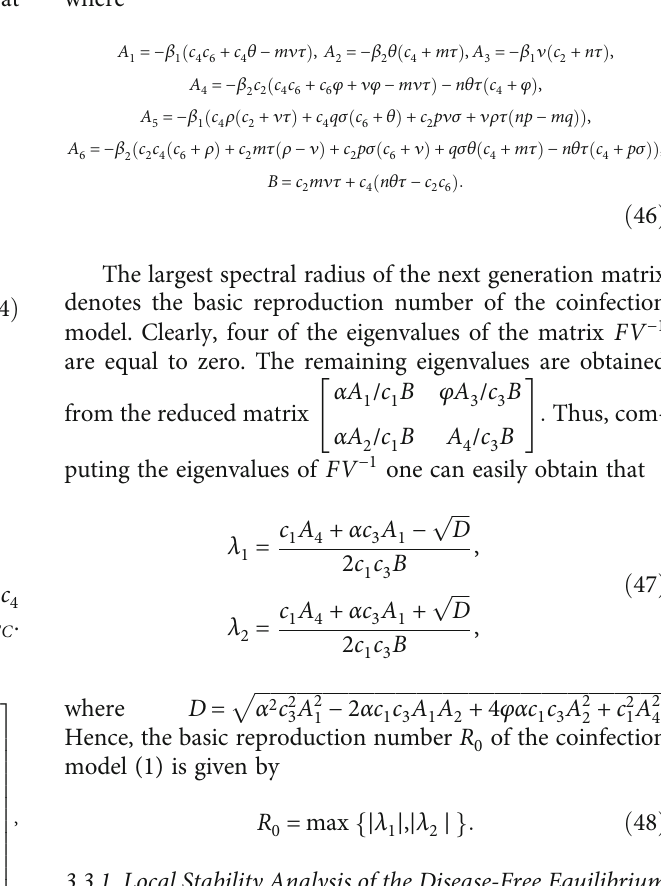
+ I TC TC ) and on the COVID-19 infected class (